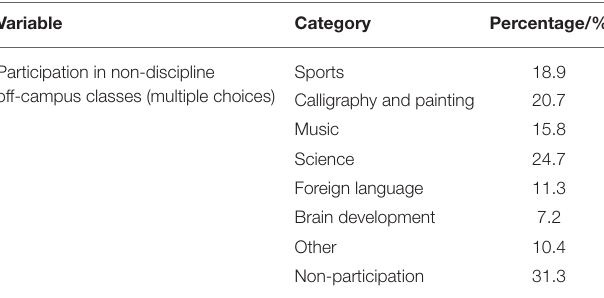
TABLE 3 | Participation in non-discipline extra-curriculum